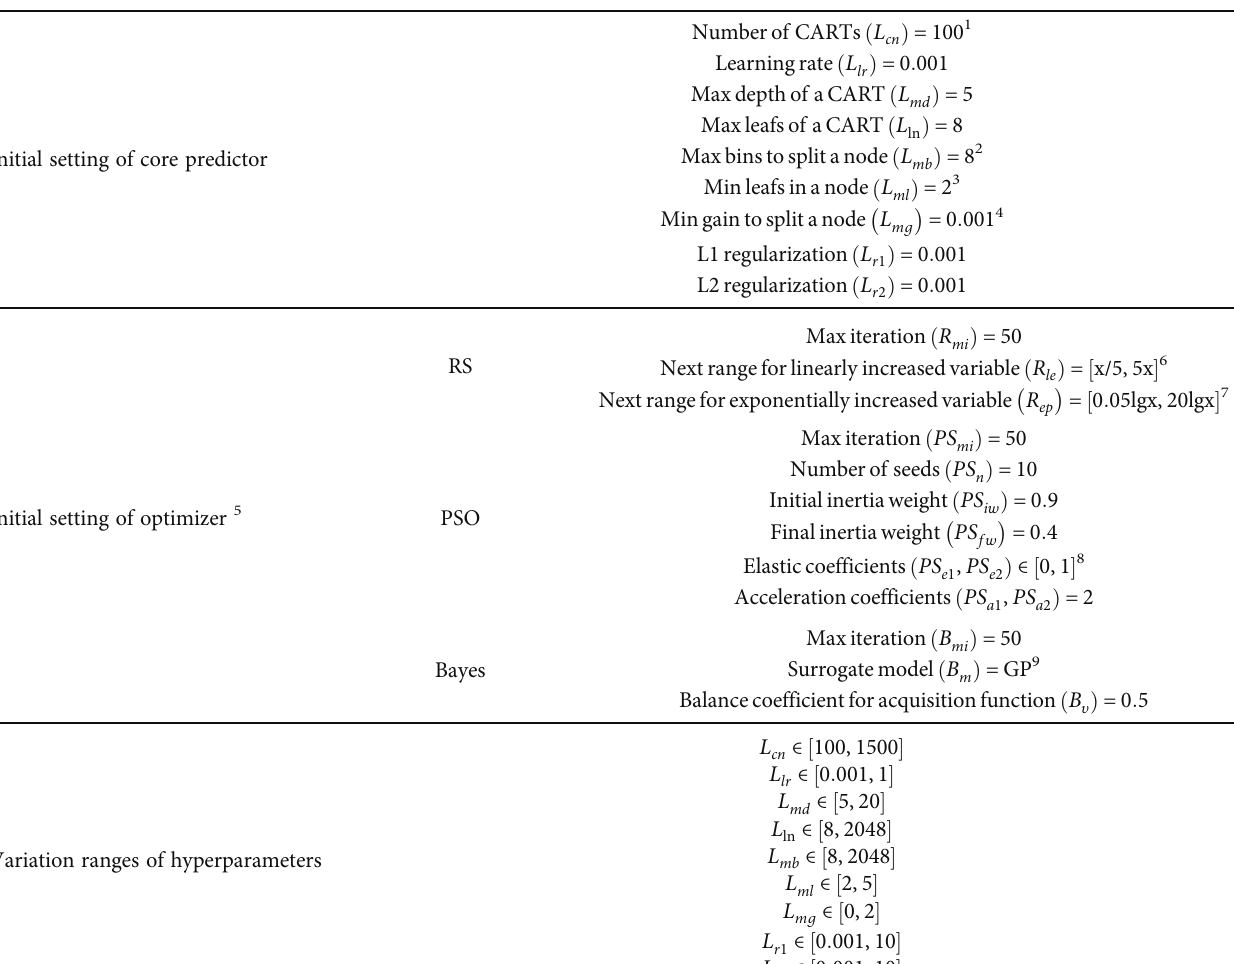
Table 4: Initial settings of light gradient boosting machine (LightGBM) predictor and optimizers, and variation ranges of hyper-parameters.